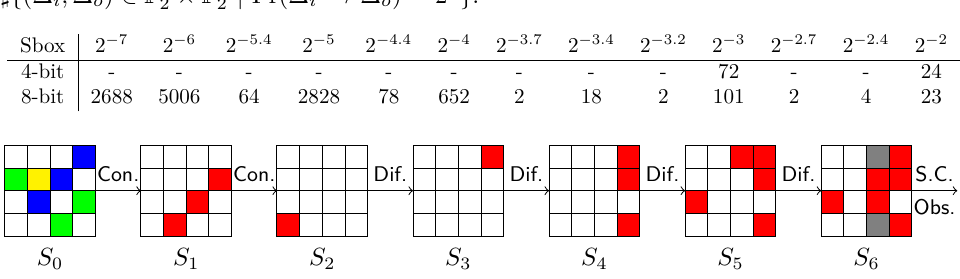
Table 3: Tally of various differential probability of the 4-bit and 8-bit SKINNY Sbox. I.e.